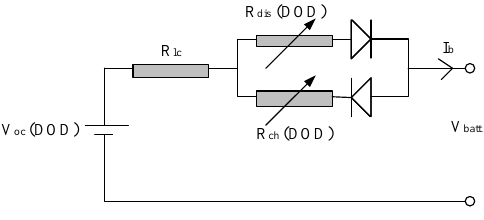
Figure 7. Equivalent model of NaS battery